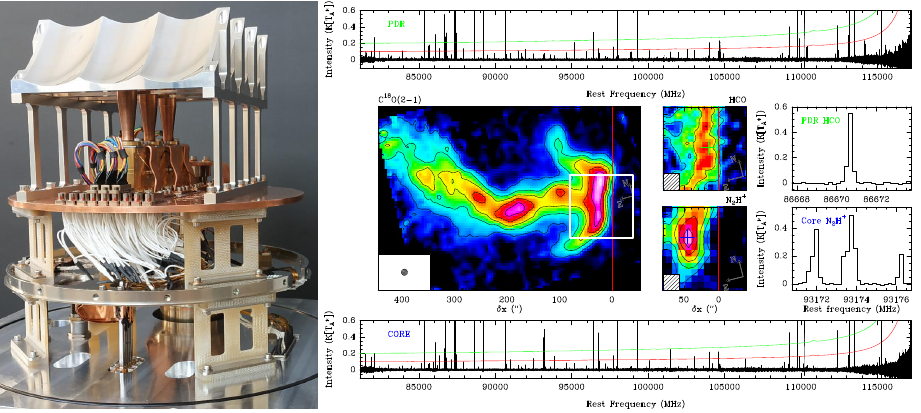
Figure 5. Left: 3mm HEMT 3-beam prototype (Courtesy of P. Serres, O. Garnier, & the IRAM front-end group). Right: Spectra (smoothed to 195kHz resolution) of the 3mm band for two di ↵ erent positions in the Horsehead Nebula, obtained by the WHISPER survey [9–11] at the IRAM-30m. The red and green curves show the 1 and 2 σ brightness levels achieved in the ORION-B field of view. The photo-dissociation region (PDR) is marked by the green cross on the HCO emission map (middle, top image). The dense core is marked by the blue cross on the N 2 H + (1 bottom image). These fields are reported as a white square on the C 18 O (2 displayed on the left panel. The middle right panels display two lines zoomed from the